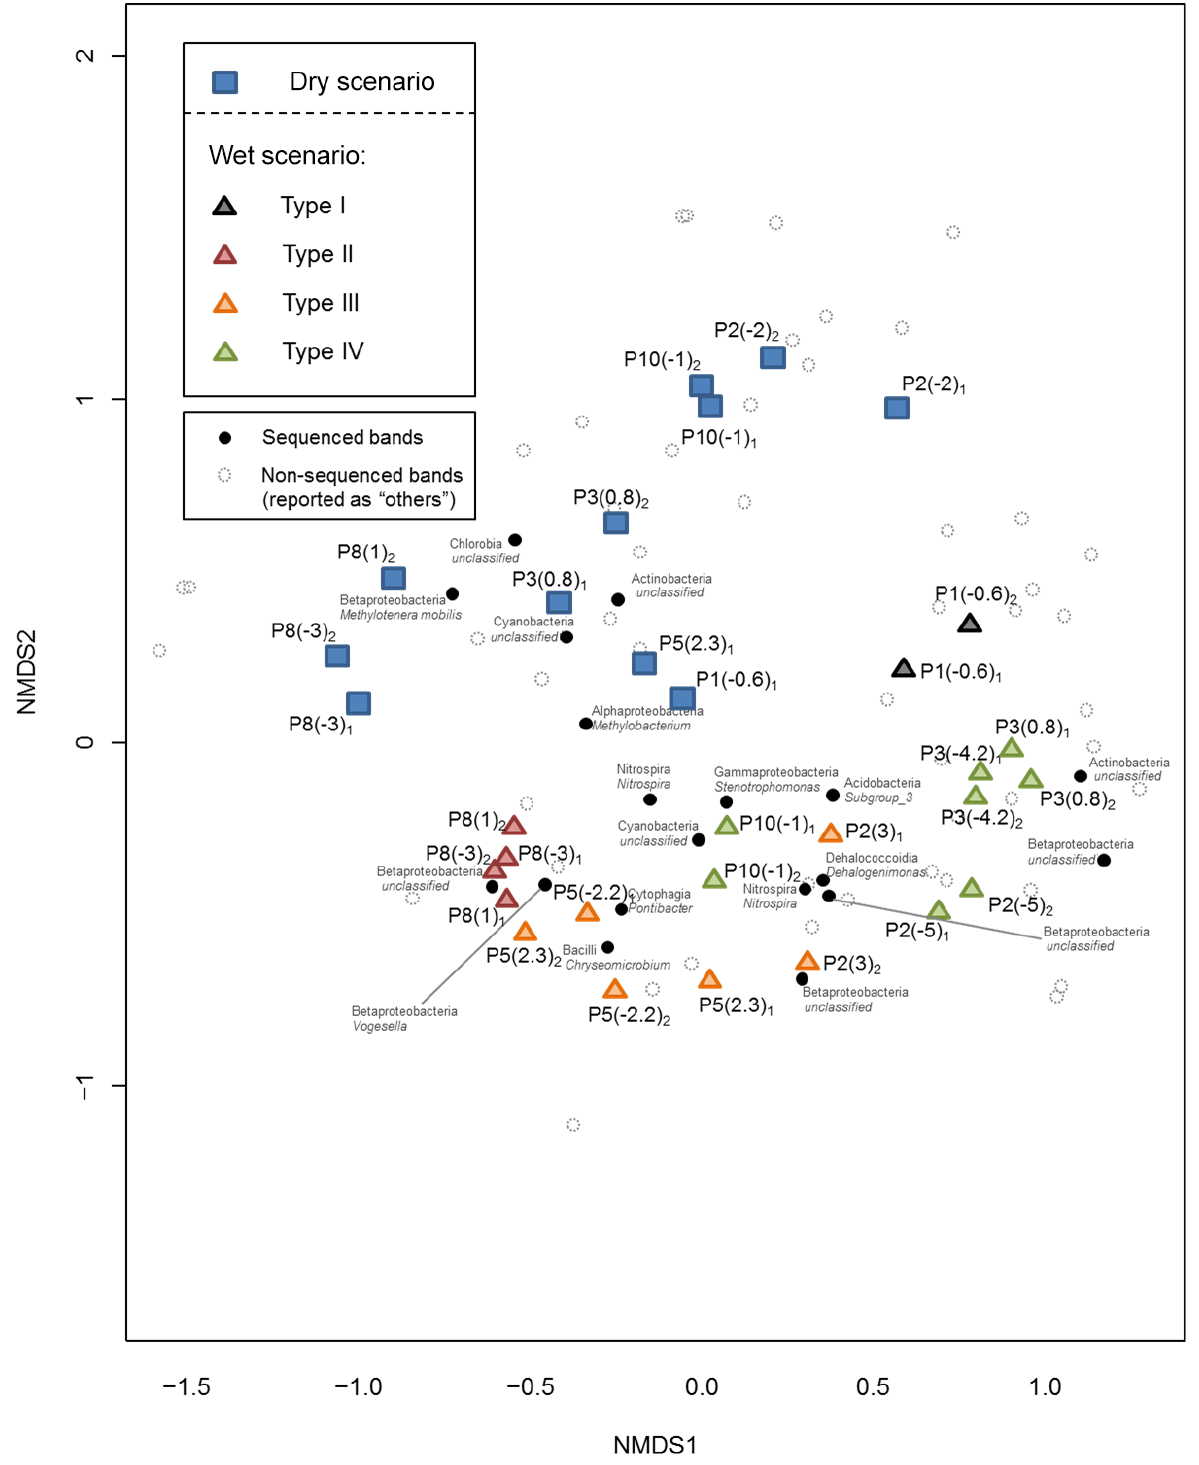
Figure 4. Non-metric multidimensional scaling clustering for all groundwater samples. Blue squares and triangles represent samples in dry and wet scenarios, respectively. Colors in triangles represent water types. Black circles correspond to band migration numbers in DGGE gels that were sequenced (phylogenetic affiliation corresponding to each black circle). Non-sequenced bands are also portrayed (empty circles).